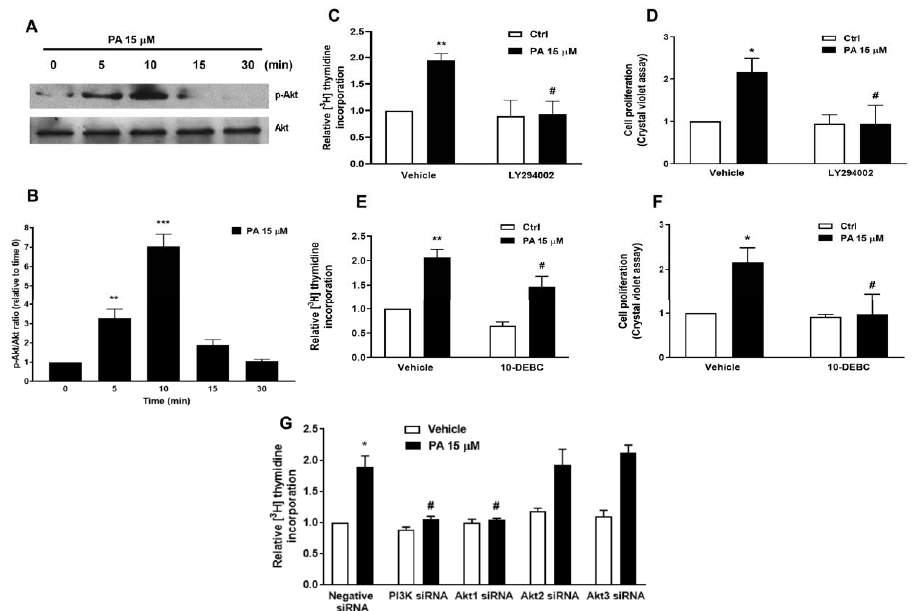
Figure 2. Involvement of the PI3-K/Akt pathway in PA-stimulated myoblast proliferation. Myoblasts were serum-starved for 24 h in DMEM supplemented with 0.1% BSA. ( A ) The cells were challenged with 15 μ M PA at the indicated times. Cell lysates were analyzed by western blotting as described in the Materials and Methods section. Phosphorylation of Akt was determined with an antibody specific to phospho-Akt (Ser 473). Equal loading of protein was monitored using a specific antibody to total Akt. Panel A corresponds to a representative blot of three independent experiments. ( B ) Results of scanning densitometry of the exposed film showing the p-Akt/total Akt ratio. Data are expressed relative to the control value without agonist and are the mean ± SEM of 3 independent experiments performed in triplicate. (** p < 0.01; *** p < 0.001). ( C ) C2C12 myoblasts were preincubated for 30 min with 1 µ M LY 294002 and then treated with 15 µ M PA for 16 h. [ 3 H]Thymidine incorporation was